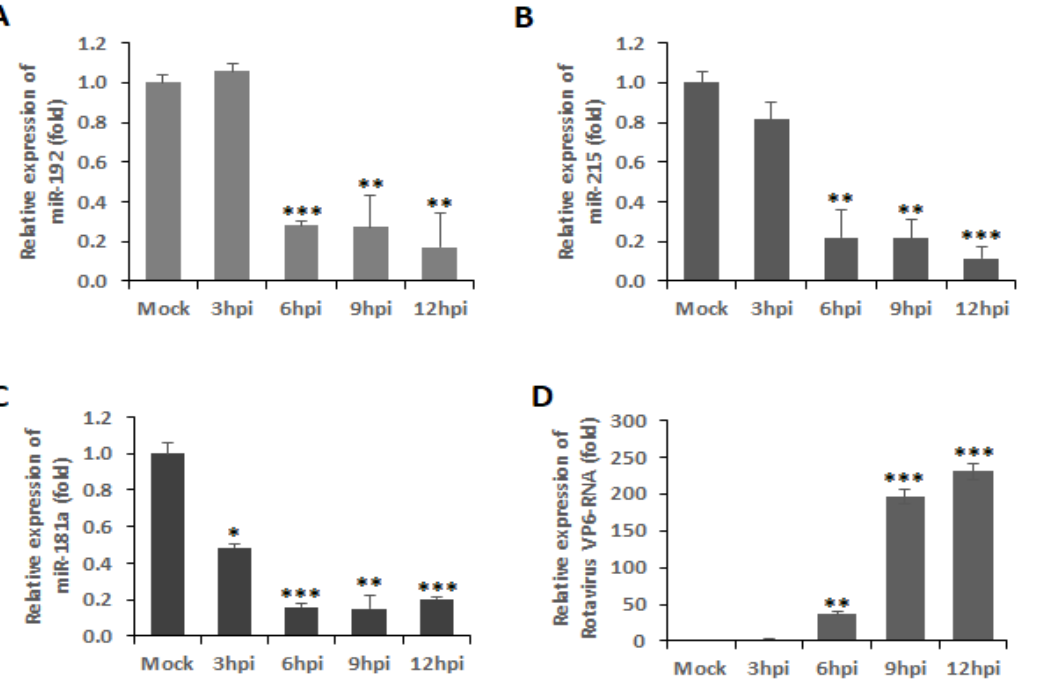
Figure 4. RV infection downregulates the expressions of miR-192, miR-215, and miR-181a. cDNA preparations from RNA isolated from 3–12 h. RV infected cells were checked for miRNA expression using qPCR. ( A – C ) Expressions of miR-192, miR-215 and miR-181a were downregulated in RV-infected MA104 cells; ( D ) Level of viral RNA (RV-VP6) was also checked in the same lysates to confirm RV infection. * p < 0.05, ** p < 0.01 and *** p < 0.001.